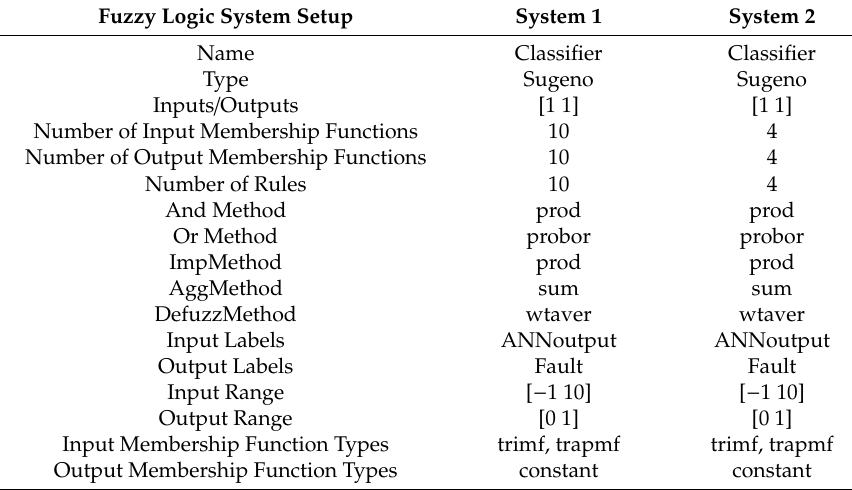
Table 7. Fuzzy logic classifier settings.